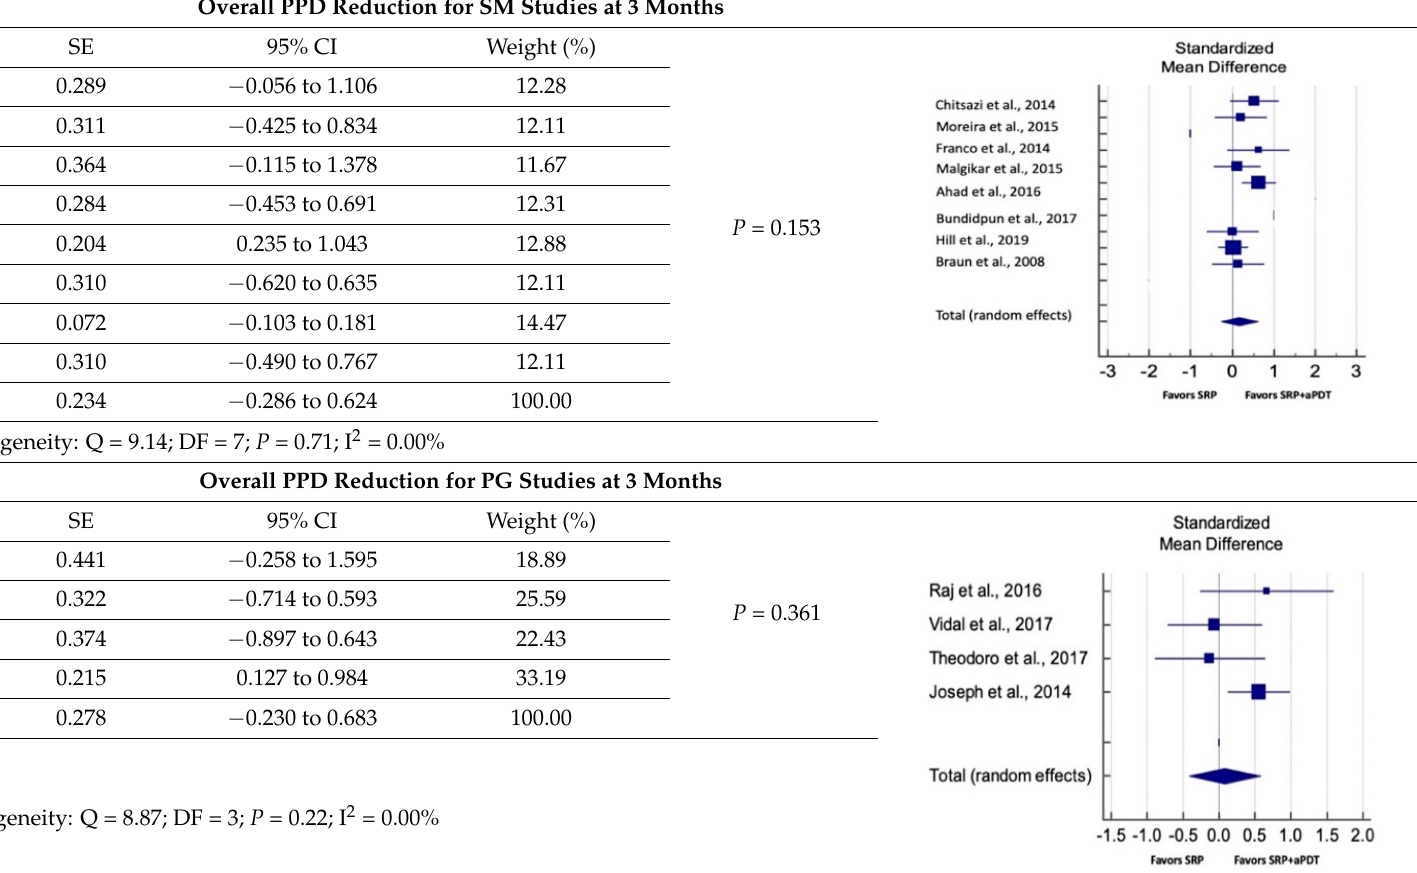
Table 6. Forest plots based on sensitivity analysis illustrating the overall PPD reduction and CAL gain at 3 months without outlier studies. Refer to Supplementary file 2 for a list of abbreviations.